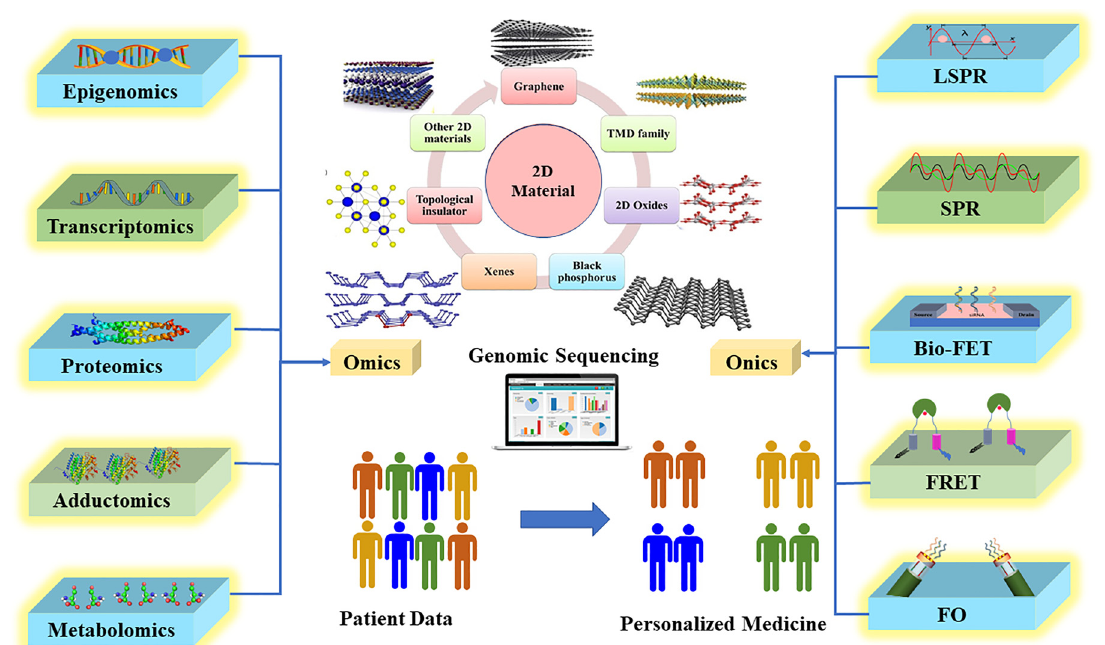
Figure 1: Schematic representation of review